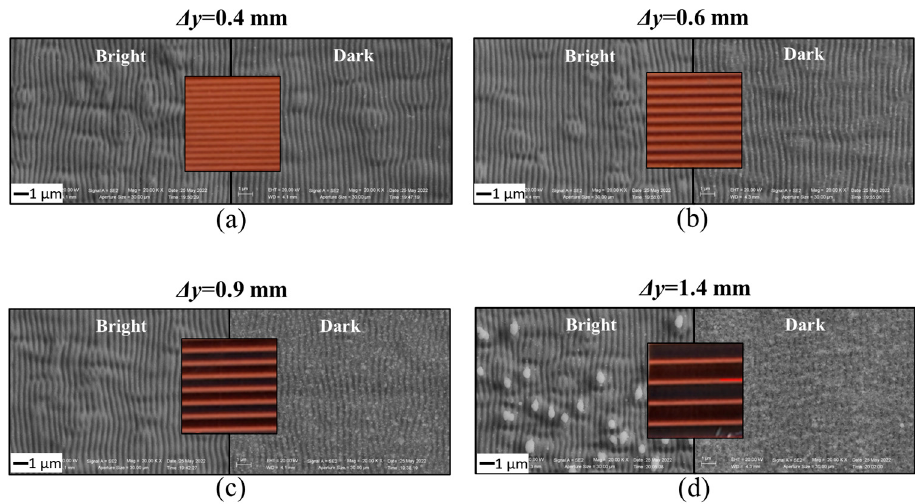
Figure 5. Photos and SEM images of the copper surface processed at 515 nm with the cylindrical lens for different values of the hatch distance Dy : ( a ) 0.4 mm, ( b ) 0.6 mm, ( c ) 0.9 mm, ( d ) 1.4 mm. The repetition rate is f p = 5 kHz and the pulse energy is E ≈ 4 µ J; the corresponding peak fluence is F p ≈ 0.42 J/cm 2 . The photos showcase the variation of the spatial disposition of the bright and dark bands as a function of the hatch distance Δ y . The SEM images display the typical surface morphological features of the bright and dark stripes in various cases.